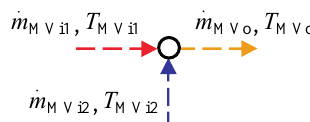
Figure A2. Model for mixing valve.